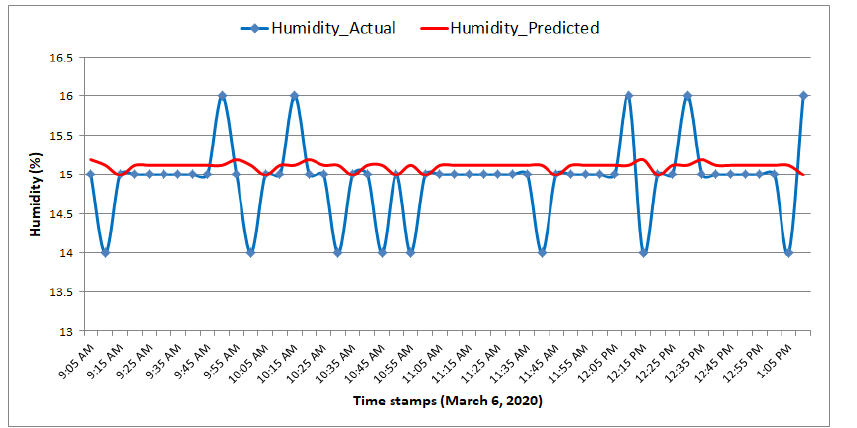
Figure 24. Predicted values of Humidity after every 5 min vs. Actual